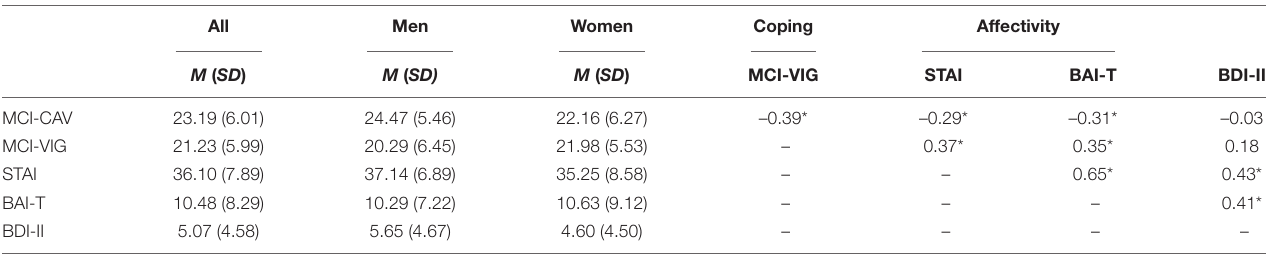
TABLE 1 | Descriptive statistics and correlations between psychometric measures.